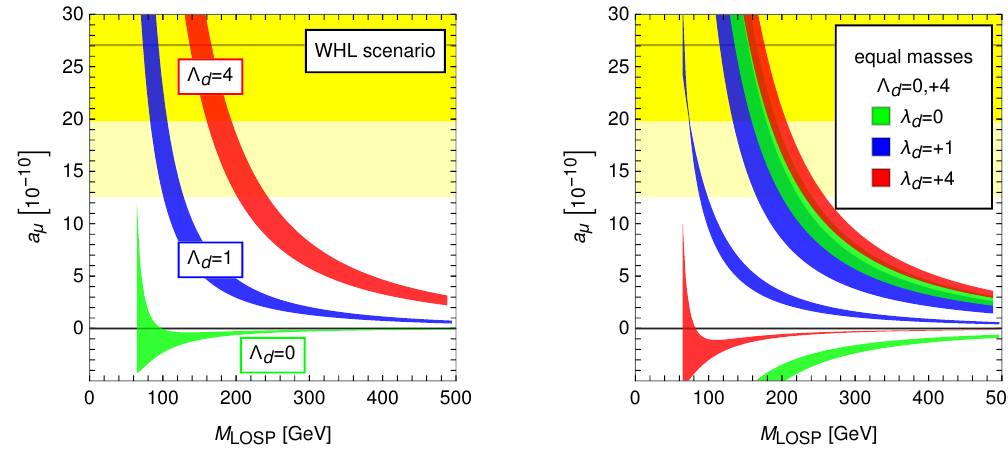
Figure 6. As (cid:12)gure 5, but for the WHL and equal-mass scenarios; in the left plot, the values of (cid:3) are indicated; in the right plot, the topmost three bands correspond to (cid:3) d = +4, the lower three bands to (cid:3) d =